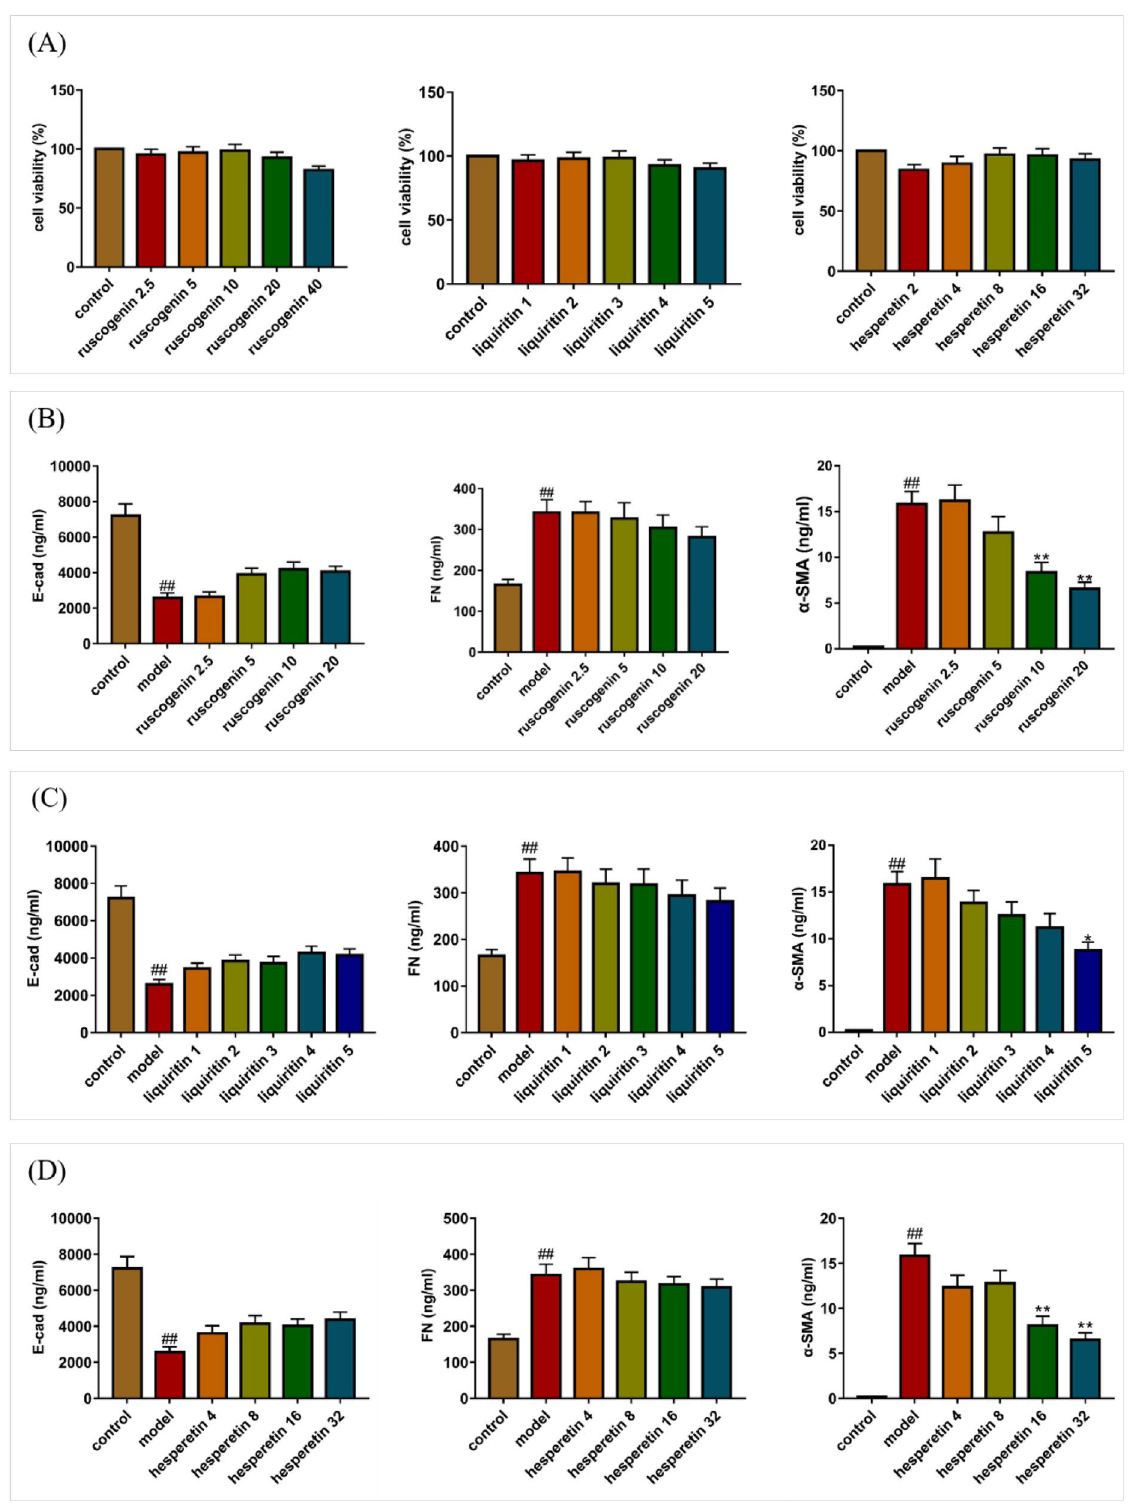
Figure 12. Effect of ruscogenin, liquiritin, hesperetin on A549 cells. ( A ) The effect of ruscogenin, liquiritin, hesperetin on A549 cell viability were detected by MTT analysis. ( B – D ) The effects of different concentrations of ruscogenin, liquiritin, hesperetin on the contents of E-cad, FN and α-SMA in pulmonary fibrosis model were determined by ELISA. Values represented as mean ± SD. ## P < 0.01 versus control group. **P < 0.01, *P < 0.05, versus model group [this figure was drawn by the GraphPad Prism software (version